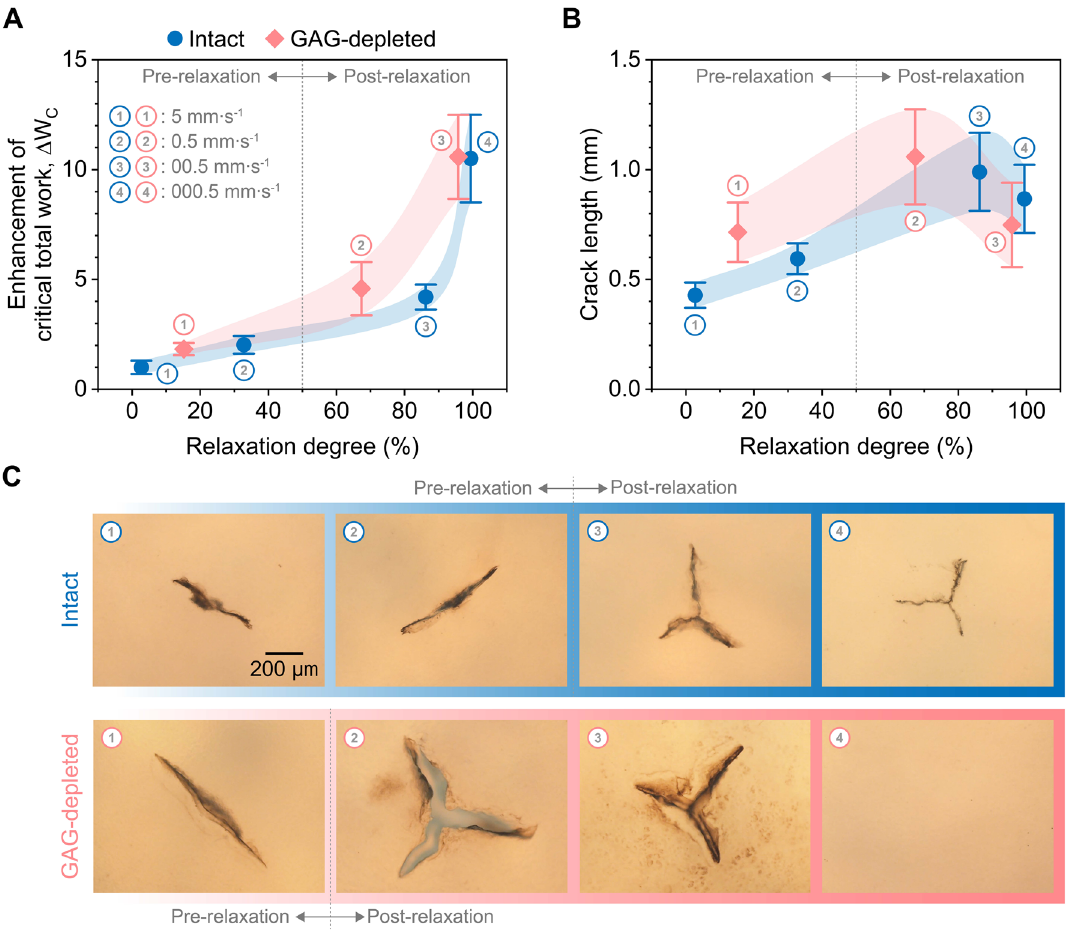
Figure 4. Relaxation-dependent crack nucleation in cartilage as a function of integrity. ( A ) Enhancement of critical total work with greater relaxation degrees. The enhancement of critical total work was obtained by dividing the data points by the minimum critical total work of intact cartilage at 5 mm s −1 . ( B ) Crack lengths. ( C ) Brightfield images of cracks. The numbers 1, 2, 3, and 4 correspond to the loading rates of 5 mm s −1 , 0.5 mm s −1 , 0.05 mm s −1 , and 0.005 mm s −1 , respectively. Averages and standard deviations (connected with the modified Bézier curves) were reported (n =